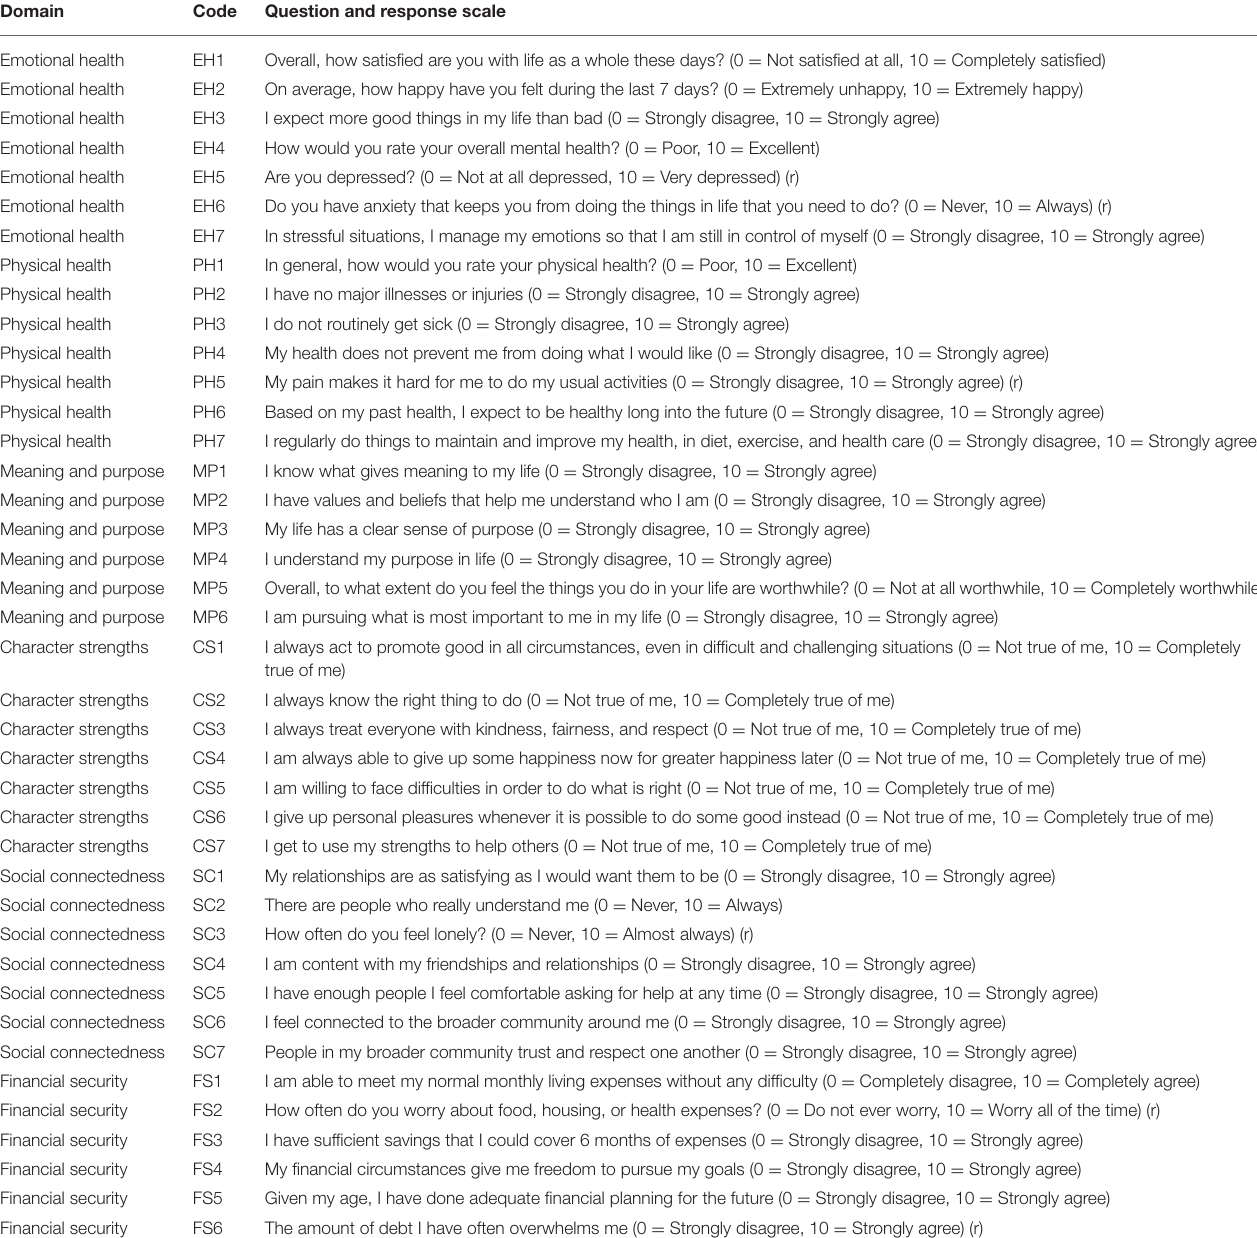
TABLE 1 | Six Well-Being Assessment components and 40